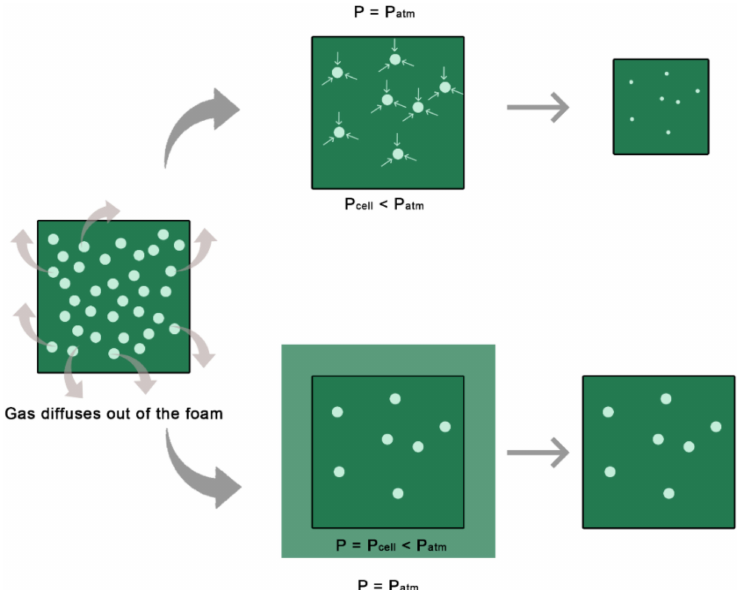
Figure 8. Negative pressure created within the cells as the gas diffused from the hot skin of the foam (top scheme). Lowering ambient pressure during the post-foaming ageing phase could counterbalance the pressure decrease inside the cells and prevent